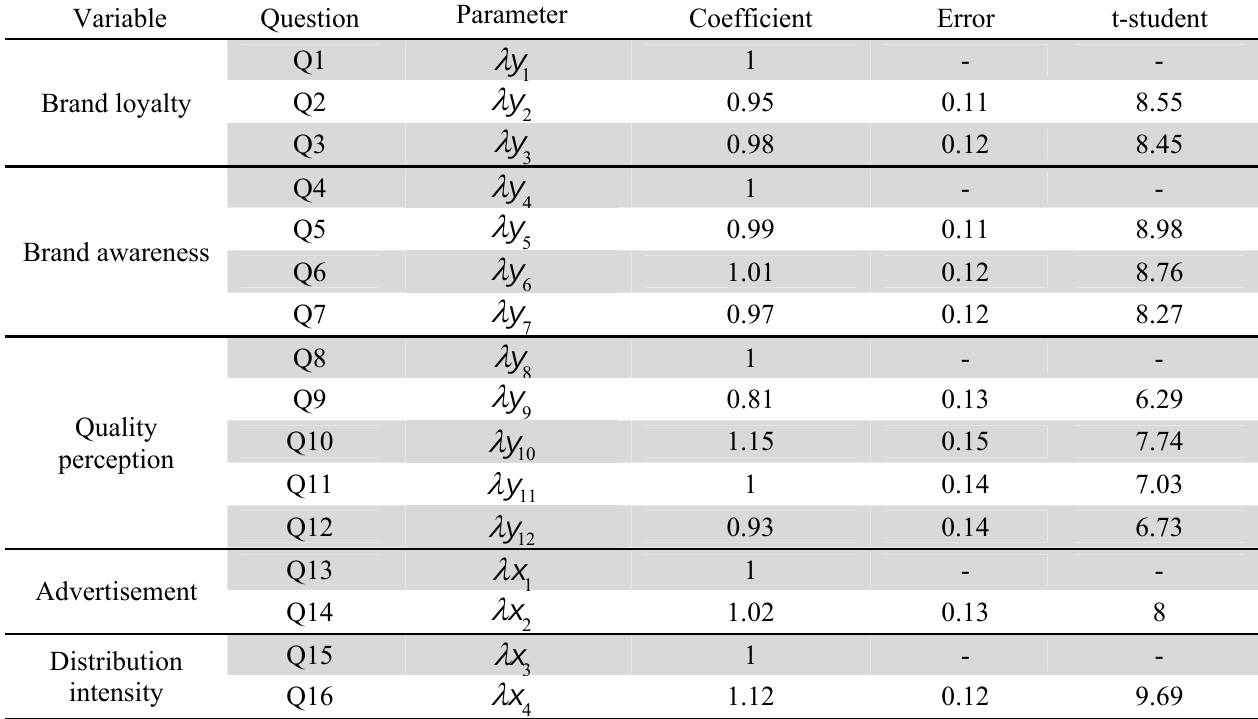
The results of structural equation modeling in terms of different